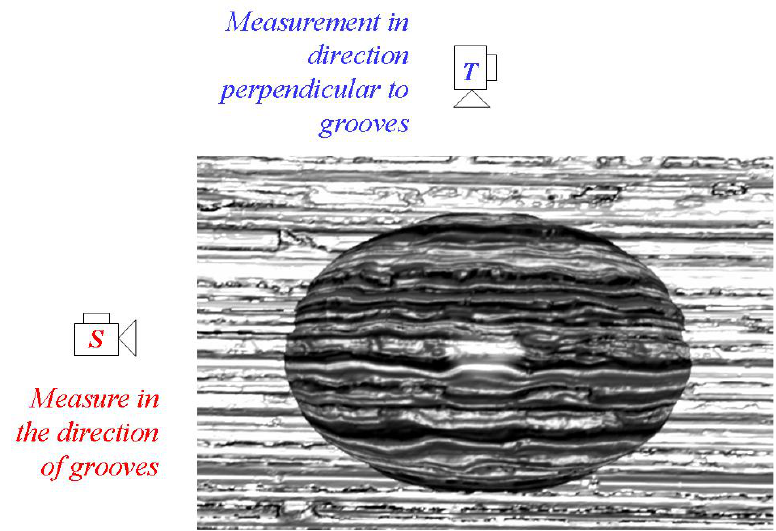
Figure 1. Schematic representation of the contact angle measurement from both directions, S and T .